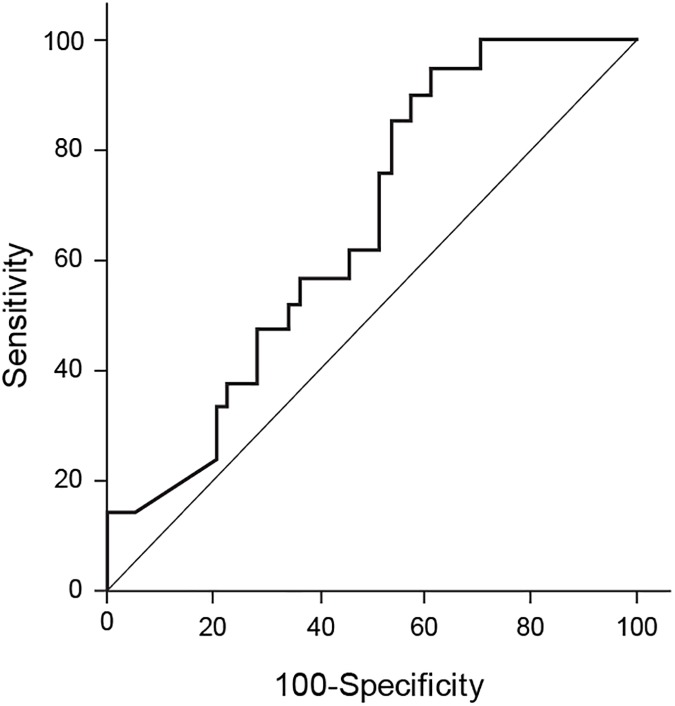
ROC curve of the fecal elastase-1 levels.